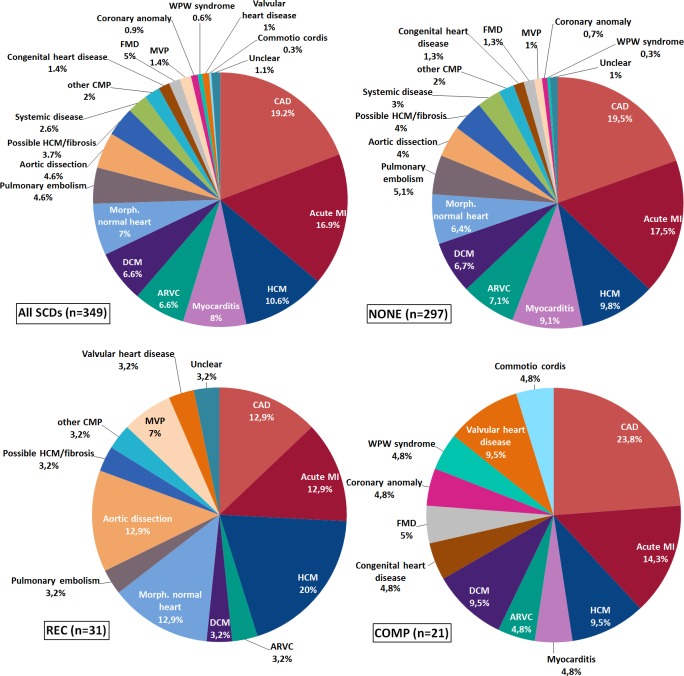
Distribution of underlying causes of sudden cardiac death and their relation to exercise.ARVC, arrhythmogenic right ventricular cardiomyopathy; CAD, coronary artery disease; CMP, cardiomyopathy; COMP, SCD related to competitions; DCM, dilated cardiomyopathy; FMD, fibrous muscular dysplasia of coronary artery; HCM, hypertrophic cardiomyopathy; MI, myocardial infarction; MVP, mitral valve prolapse; NONE, SCD not related to physical activities; REC, SCD associated with physical activities other than competitions.